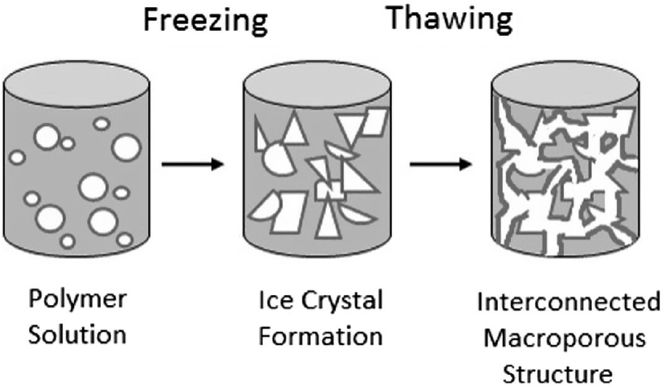
Figure 6. Fabrication of cryogel scaffolds demonstrating the crosslinking and subsequent freezing of the polymer solution, forming a sponge ‐ like, macroporous structure [135]. the polymer solution, forming a sponge-like, macroporous structure